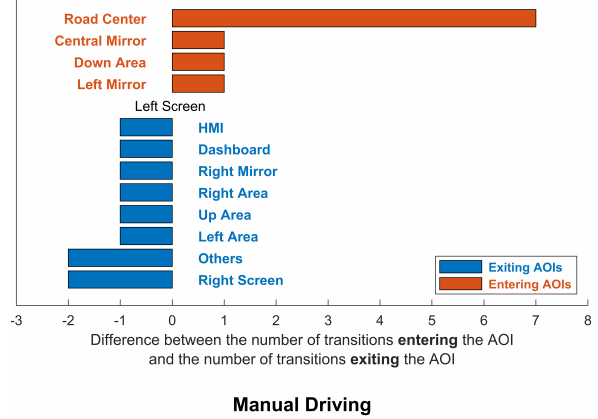
Figure 5: Visualisation of exiting AOIs (blue) and AOIs (or- ange) for manual driving